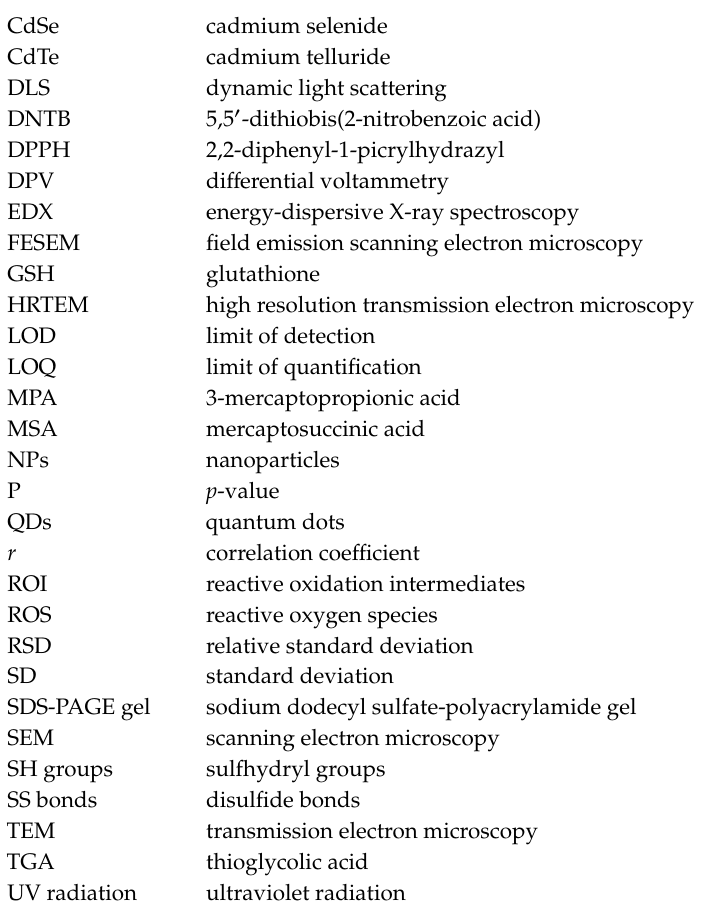
Figure S1: Scanning electron microscopy (SEM) (a), energy dispersive X-ray spectroscopy (EDX) elemental mapping (b) and high-resolution transmission electron microscopy (HRTEM) (c) of CdTe quantum dots (QDs). (A) Yellow, (B) green, (C) red and (D) orange CdTe QDs. Further experimental details are described in the Materials and Methods